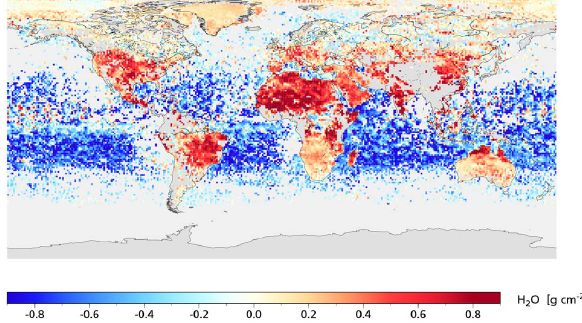
Figure 10. SCIAMACHY-ESA and ECMWF mean WVC differences (SCIAMACHY-ESA Fig. 10. SCIAMACHY-ESA and ECMWF mean WVC differ- minus ECMWF WVC amounts) for June 2005 for cloud free conditions selected according to ences (SCIAMACHY-ESA minus ECMWF WVC amounts) for the SPICI cloud products. Both data sets have been averaged to a ground pixel size of June 2005 for cloud-free conditions selected according to the SPICI approximately 120 km x 30 km. cloud products. Both data sets have been averaged to a ground pixel size of approximately 120km × 30km.